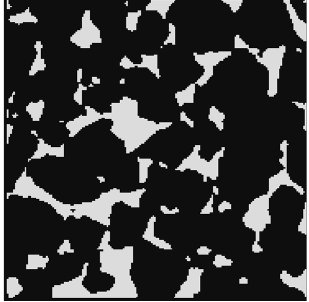
Figure 3: Training image of 2D micro-CT thin section